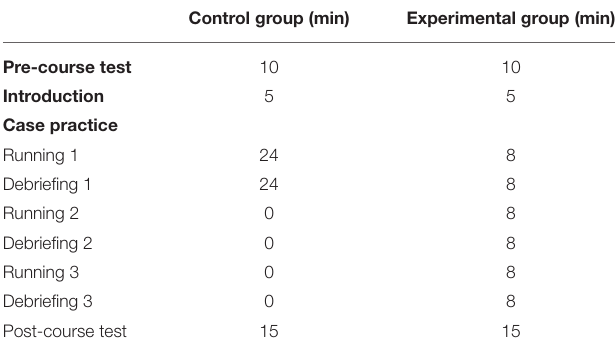
TABLE 1 | Time distribution of the experimental and control